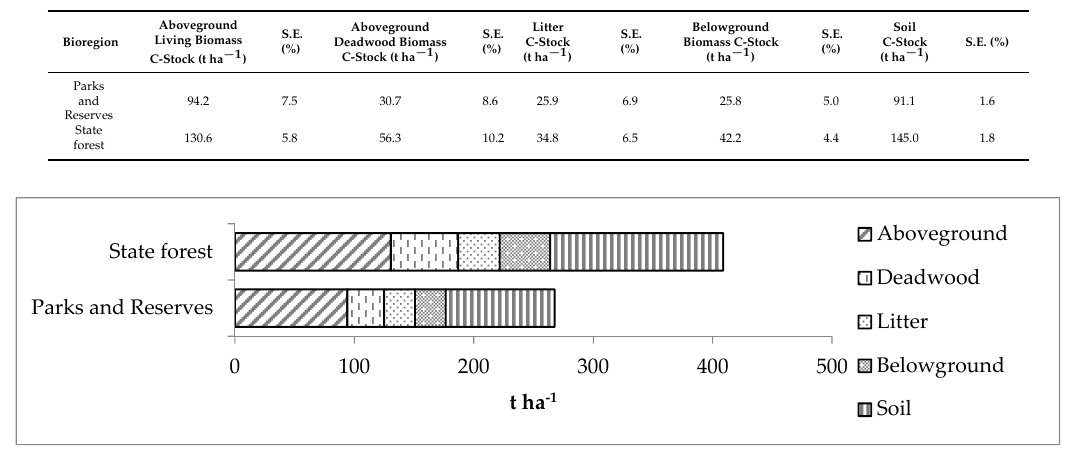
Figure 1. Carbon stock per hectare in the Victorian tenure categories across the five carbon pools.